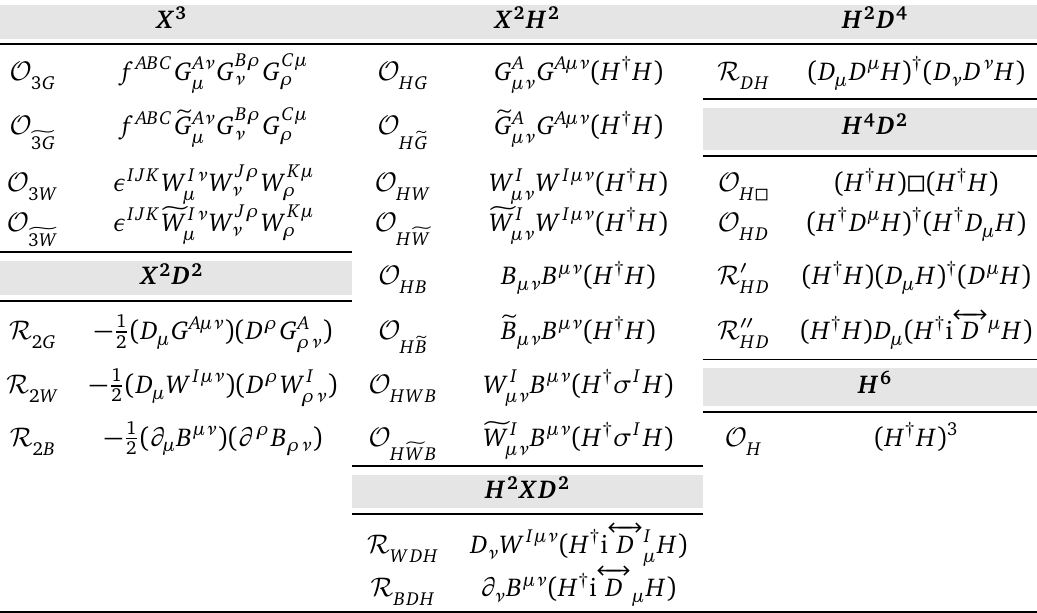
Table 1: Physical and redundant bosonic